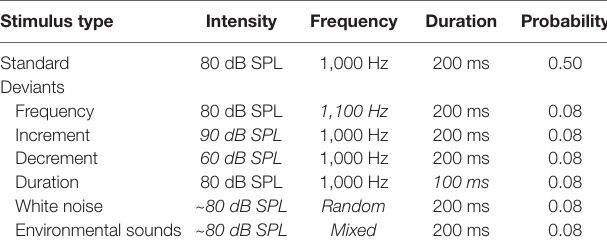
TaBle 1 | The intensity, frequency, duration, and probability of the standard stimulus and the six deviant stimuli in the optimal paradigm. stimulus type intensity Frequency Duration Probability Standard 80 dB SPL 1,000 Hz